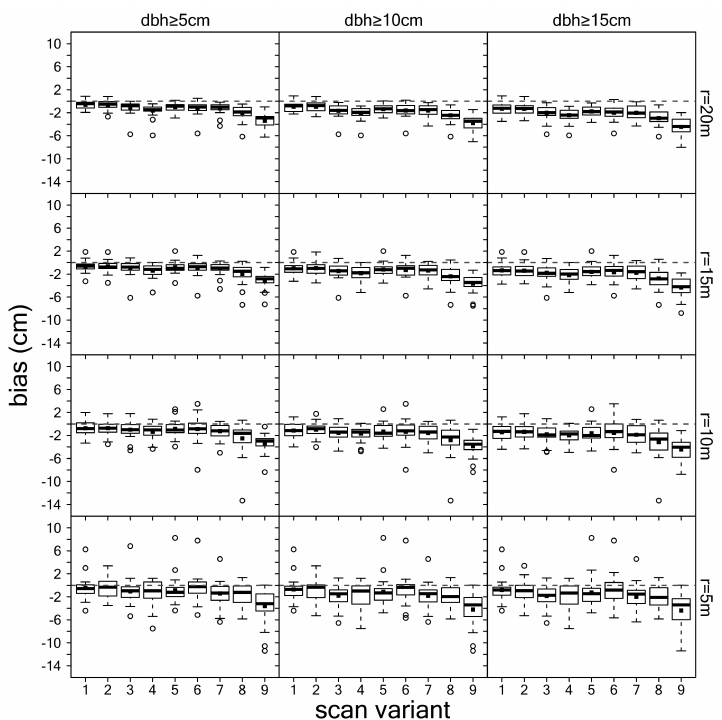
Figure A3. dbh bias in cm for di ff erent scan variants, lower dbh thresholds, and plot radii. Black squares represent mean dbh bias.